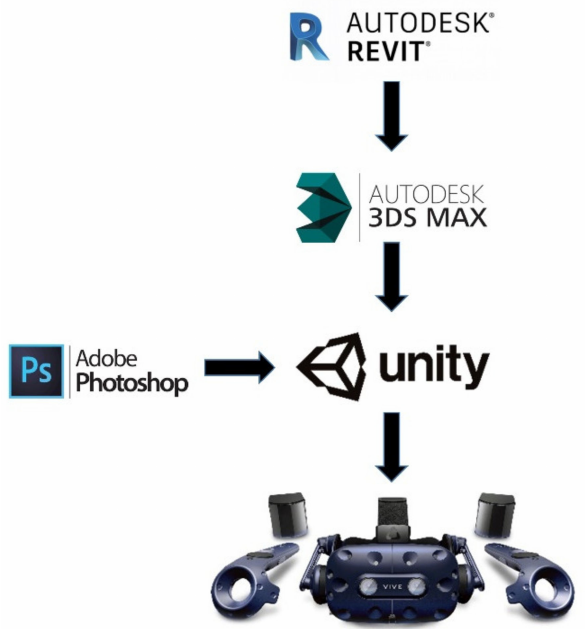
Figure 4. Programs used to create the virtual reality (VR) experience and workflow